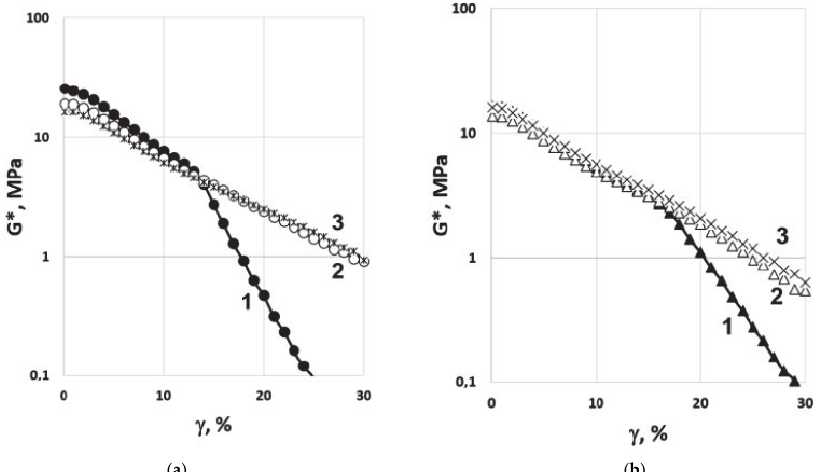
Figure 7. Plots of the complex modulus (G*) versus shear strain ( γ ) in the LAS test at temperature 16 ° C: ( a ) Bit-A—1; MB-A(0)—2; MB-A(20)—3; ( b ) Bit-B—1; MB-B(0)—2; MB-B(5). Figure 8 shows the dependence tangent of phase angle (tg¦Ä) versus shear strain ( γ ) recorded during testing at 16 and 7 ° C. As can be seen, the modified binders in all cases show less sensitivity to cyclic deformation.